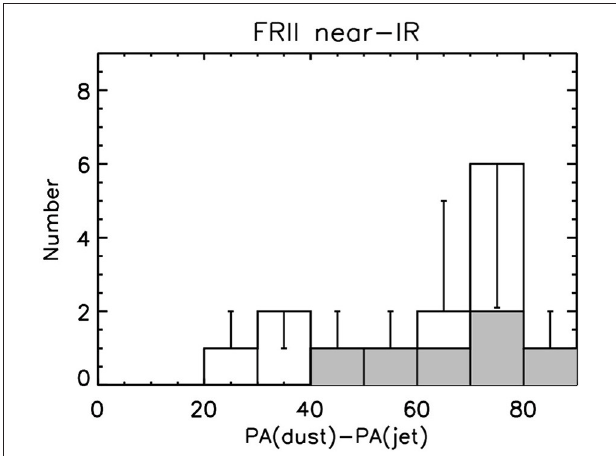
FIGURE 3 | The distribution of the offsets between the radio jet and the ∼ 2 kpc-scale dust features of our sample (filled bars), and from the literature (open bars; Madrid et al.,